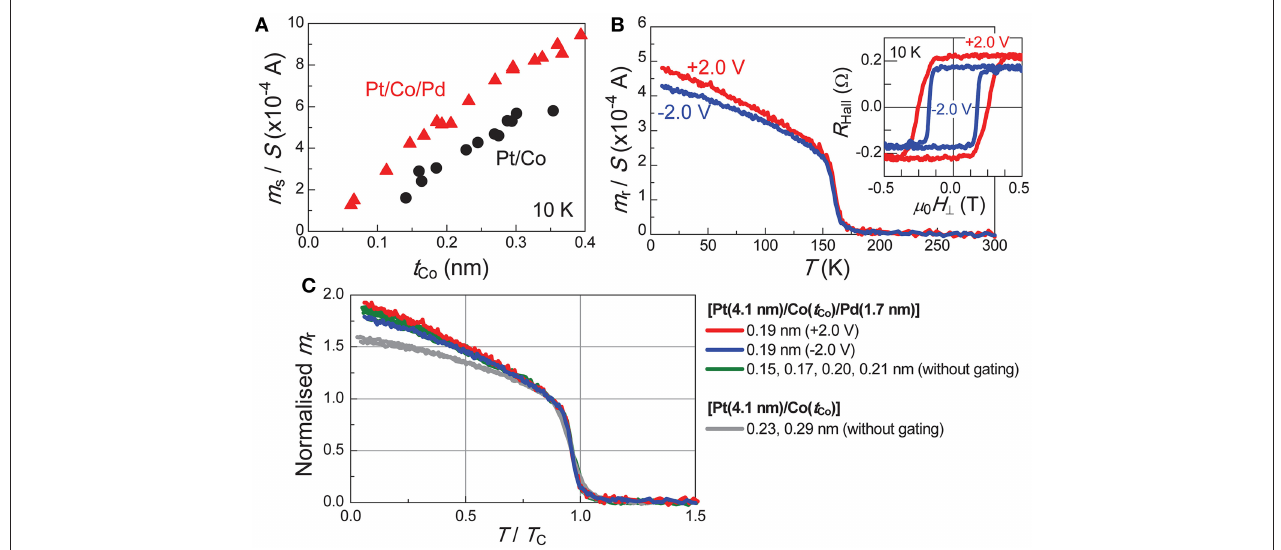
FIGURE 2 | Electric field effect on the induced magnetic moment in Pd. (A) The Co thickness t Co dependence of the saturation magnetic moment per unit area ( m s / S ) at 10 K for the Pt(4.1nm)/Co( t Co ) and Pt(4.1nm)/Co( t Co )/Pd(1.7nm) samples. (B) The T dependence of the remanent magnetic moment per unit area ( m r / S ) for the Pt(4.1nm)/Co(0.19nm)/Pd(1.7nm) sample under positive ( + 2V) and negative ( − 2V) V G . The inset shows the magnetic hysteresis loops for both V G at 10 K. For the hysteresis measurement, the anomalous Hall effect was used. (C) The T / T C dependence of the normalized m r for the Pt/Co and Pt/Co/Pd samples with various t Co . The m r was normalized at T / T C = 0.87 . All data points without gating were sandwiched by the positively and negatively gated data points, indicating that the induced magnetic moment at the surface of the Pd layer was modulated by the application of an electric